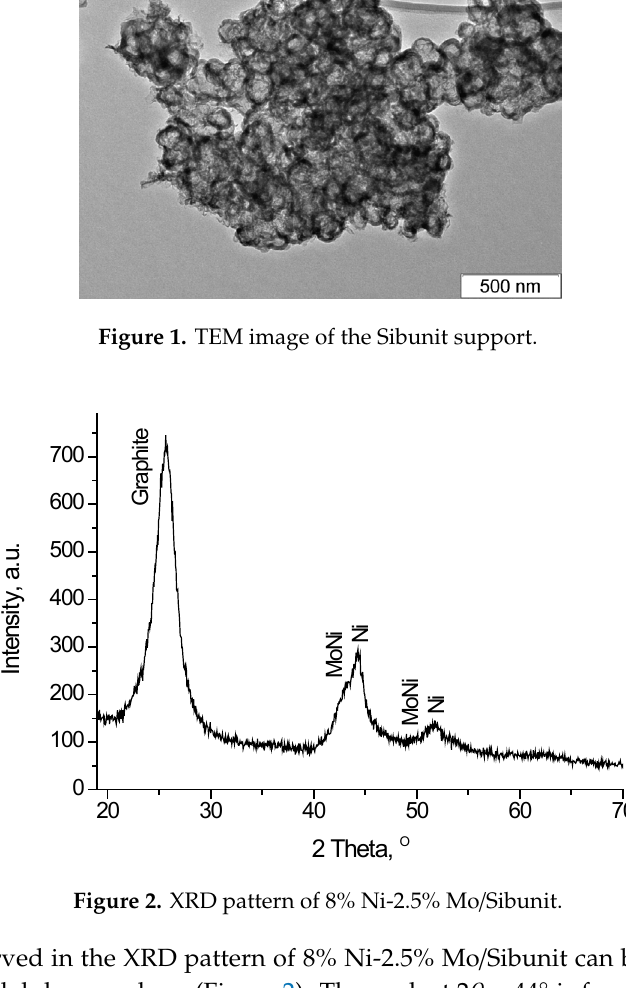
Figure 1. TEM image of the Sibunit support.